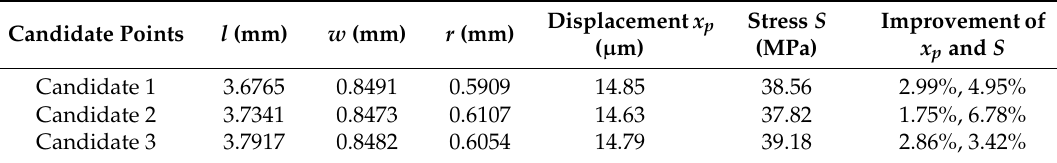
Table 3. Comparisons among candidates.